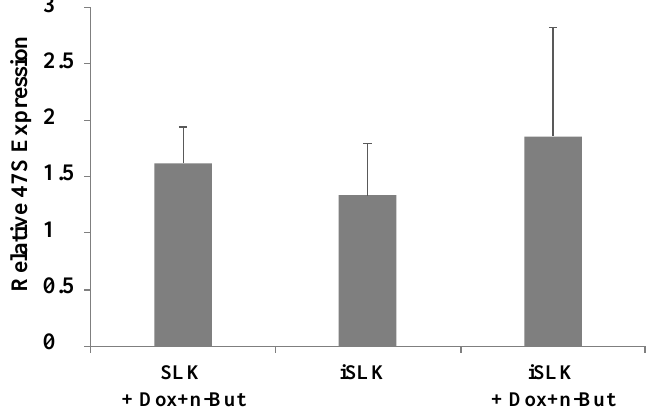
Figure 6. Lytic reactivation does not alter expression levels of the 47S pre-rRNA. Uninfected SLK and BAC16-mCherry-ORF45-infected iSLK cells were treated for 48 h with 1µg/mL Dox and 1 mM n-Butyrate to induce lytic reactivation. Untreated cells were used as controls. Lytic reactivation was confirmed by expression of mCherry-ORF45 in ~80% of cells. The 47S pre-rRNA levels were determined using RT-qPCR with primers that target the 5′ external transcribed spacer (ETS) of pre-rRNA, and the results obtained were normalized to 18S rRNA. Data are presented relative to untreated SLK cells, and are from the averages of five biological repeats, each including three technical replicates. Error bars represent standard deviations. No statistically significant differences between SLK and iSLK cells prior or after lytic reactivation were obtained (one-way ANOVA and one-sample t test).